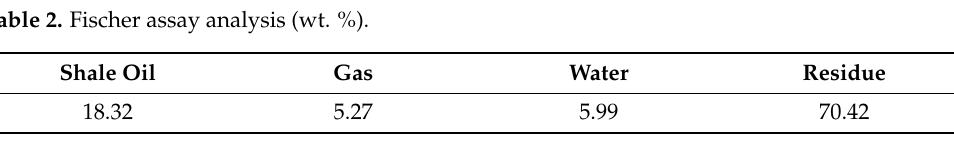
Table 3. Composition of the Huadian oil shale.